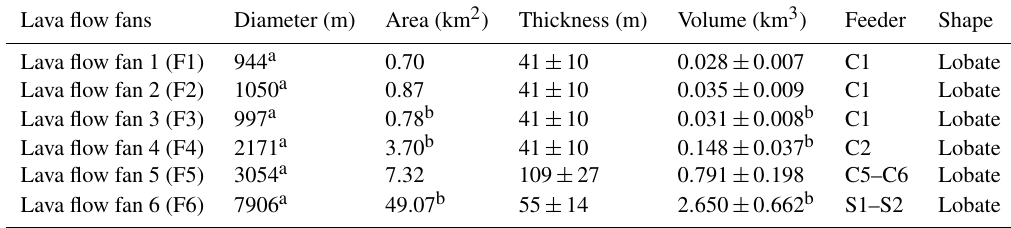
Table 4. Dimensions of lava flow fans.